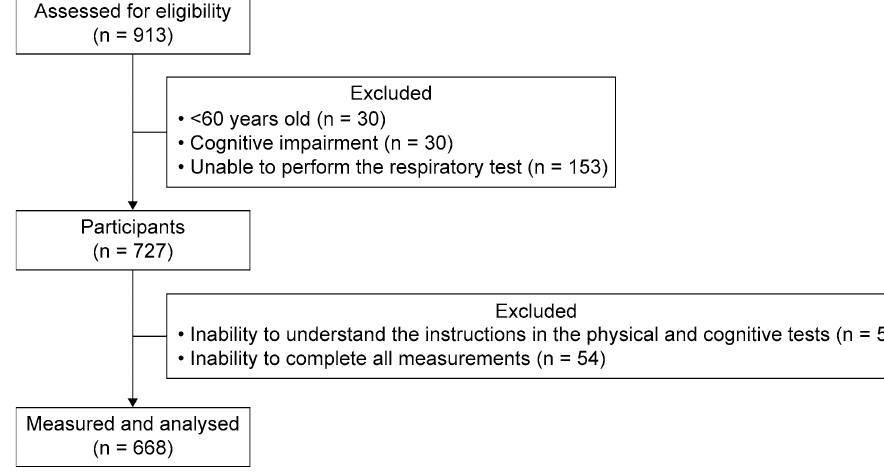
Figure 1. Flowchart illustrating selection of study participants.